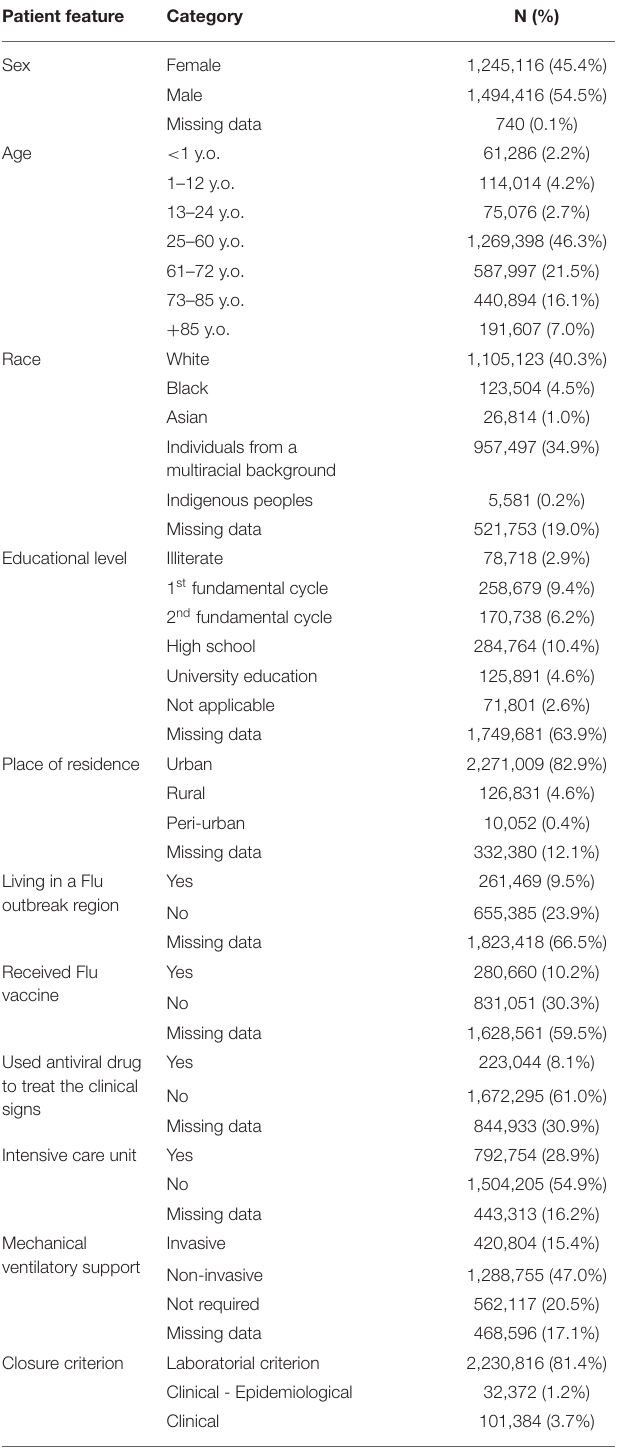
TABLE 2 | Features of the hospitalized patients due to severe acute respiratory infection (SARI) in Brazil for demographic information, follow-up during the hospitalization, and outcomes during the Coronavirus Disease (COVID)-19